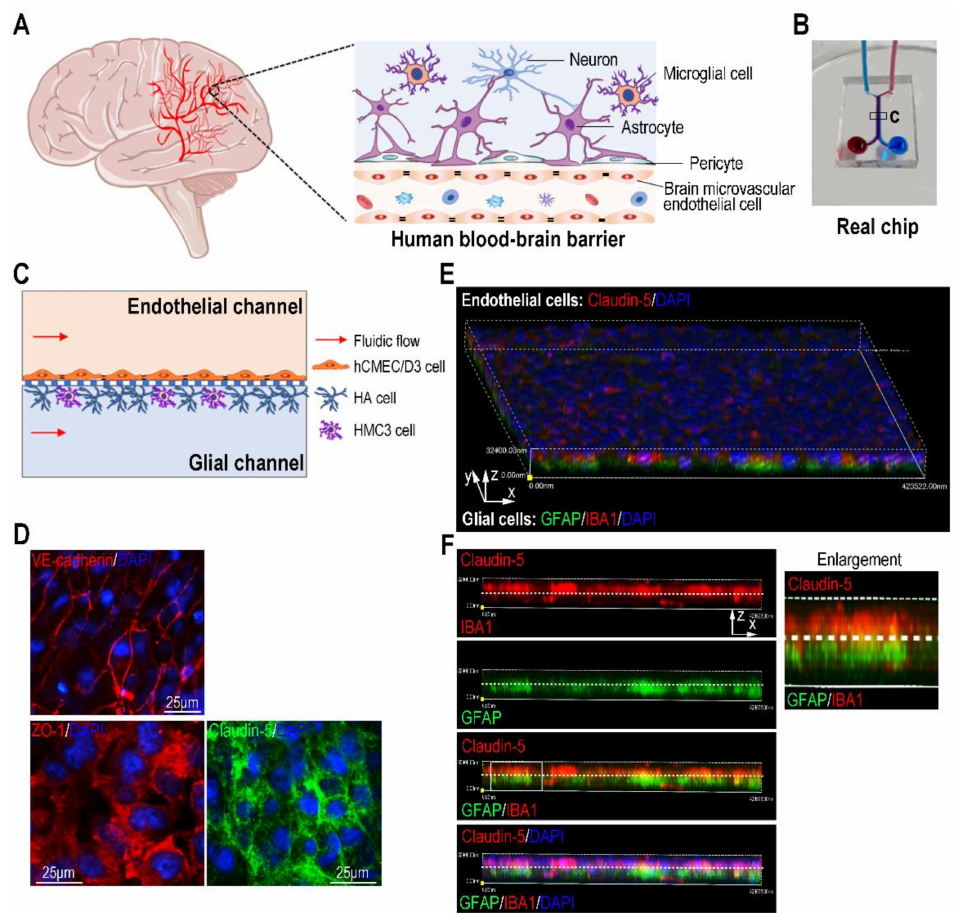
Figure 2. Establishing a human BBB chip. ( A ) A schematic description of human brain and blood– brain barrier (BBB). ( B ) A real image of a BBB chip. Red and blue inks were poured into two channels. ( C ) Schematic description of the BBB chip by co-culturing of human brain microvascular endothelial cells, astrocytes and microglial cells on the porous PET membrane. ( D ) Representative confocal images of brain endothelial cells immunostained for VE-cadherin, ZO-1 and Claudin-5 on chip device under flow culture condition for 3 days ( n = 3). ( E ) A 3D confocal image showed the BBB barrier interface on chip device. The BBB barrier interface was formed by co-culture of human brain microvascular endothelial cells (hCMEC/D3 cells; Clauding-5 staining), human astrocytes (HA cells; GFAP staining) and microglial cells (HMC3 cells, IBA1 staining) on the porous membrane under fluid flow conditions ( n = 3). ( F ) Side views of the BBB interface identified by Claudin-5 in human brain microvascular endothelial cells, GFAP in astrocytes and IBA1 in microglial cells ( n = 3). The area indicated by the white box was enlarged on the right. The white dotted line indicated the porous